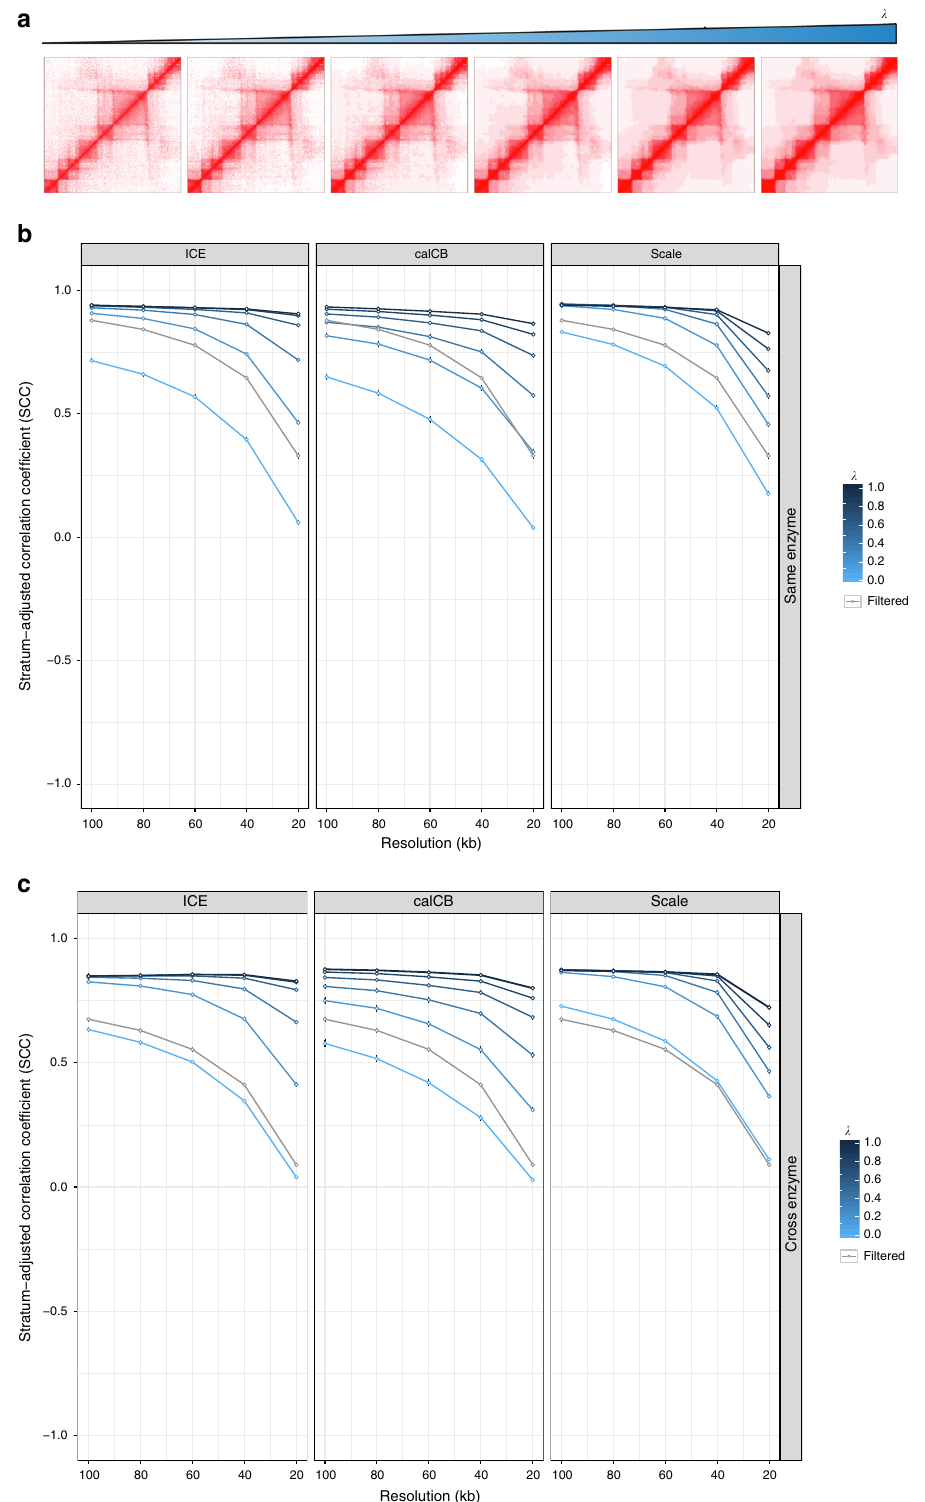
Fig. 2 Fused two-dimensional lasso improves reproducibility of Hi-C contact matrices (high sequencing depth = 80 million intrachromosomal read pairs). a Example of application of fused two-dimensional lasso on a Hi-C contact matrix focused on a 8 Mb locus on chromosome 8 for different values of parameter λ . b Stratum-adjusted correlation coef fi cient values are improved by increasing the value of fused lasso parameter λ for matrices estimated with ICE, calCB and our simple scaling method (same enzyme). c Stratum-adjusted correlation coef fi cient values are improved by increasing the value of fused lasso parameter λ for matrices estimated with ICE, calCB, and our simple scaling method (cross enzyme). As a baseline control, stratum-adjusted correlation coef fi cients of Hi-C contact matrices generated by the naive fi ltering method are marked by the gray line in each